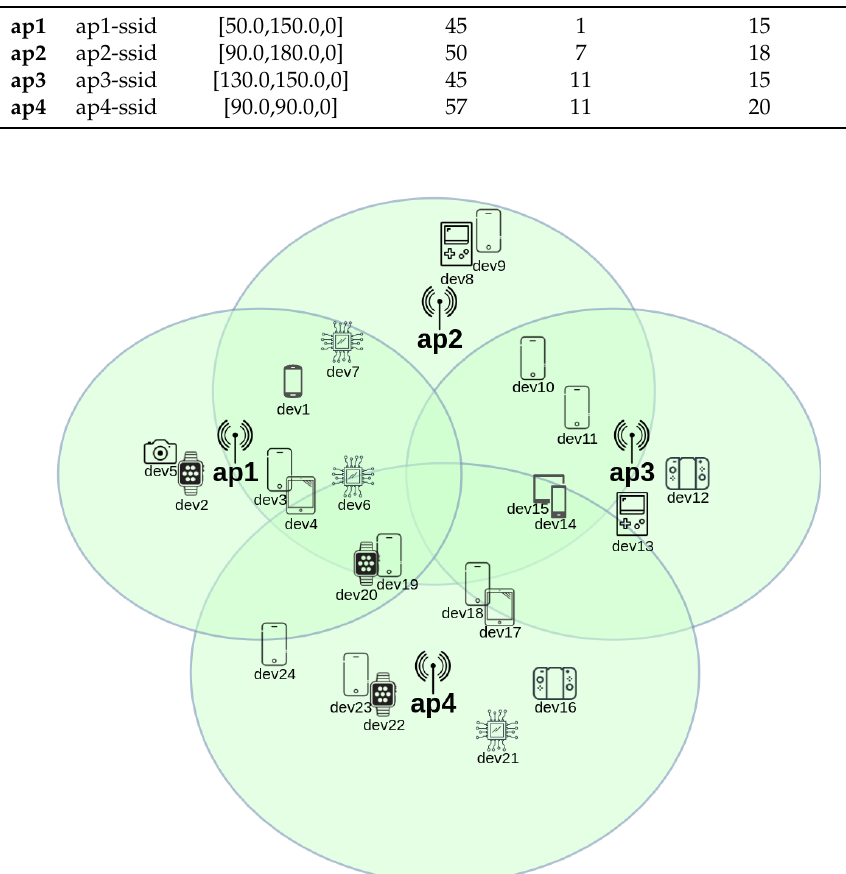
Figure 2. Dataset scenario